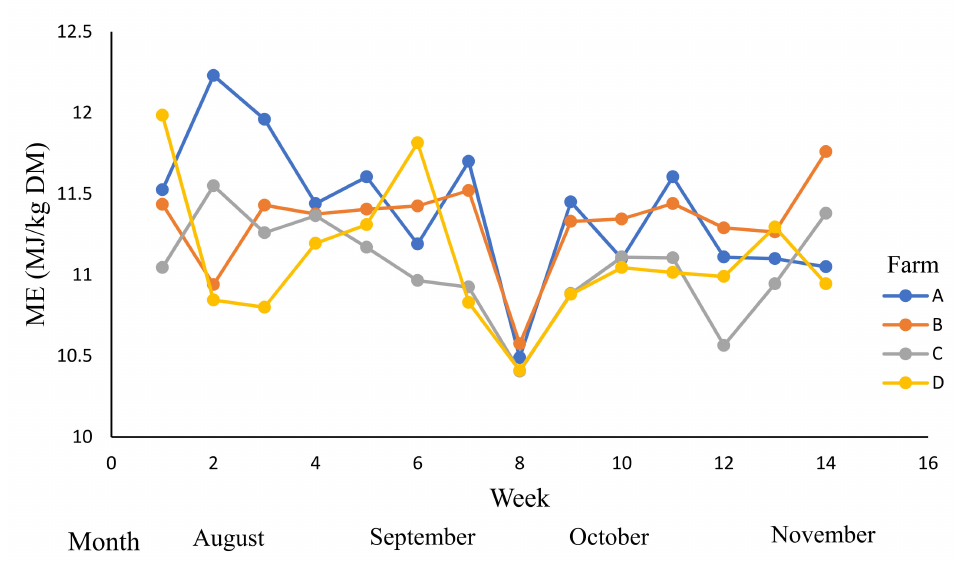
Figure 5. The variations in the metabolisable energy (ME) content (MJ kg dry matter (DM)) across dairy farms (A–D) during winter and spring; 0–14 weeks (August to November